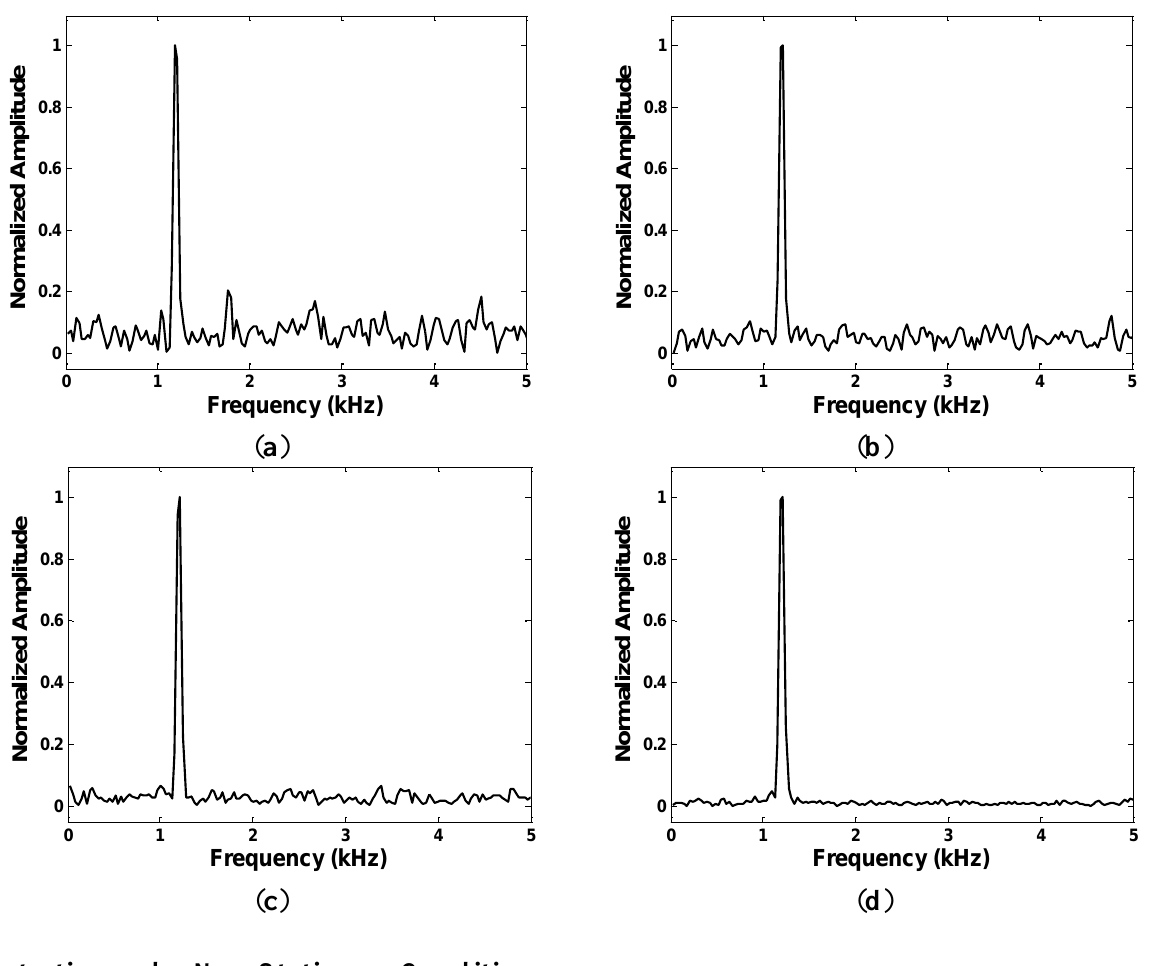
Figure 3. Output signal spectrum under echo SNR of ( a ) 0 dB; ( b ) 3 dB; ( c ) 10 dB; and ( d ) 20